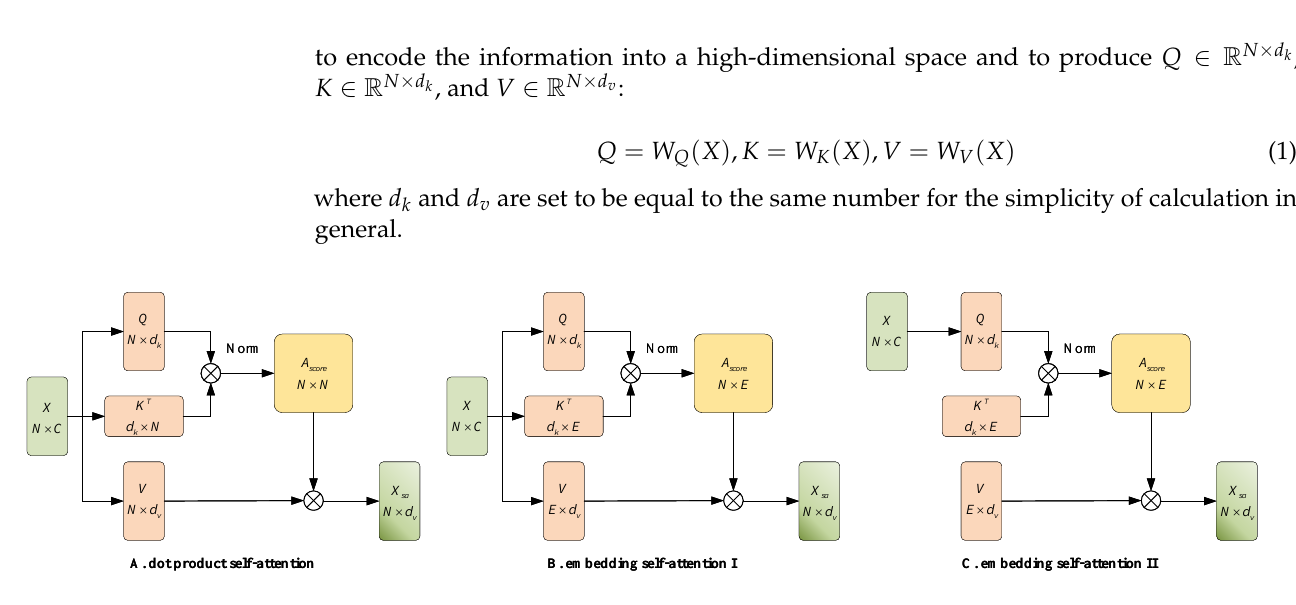
Figure 3. Dot product self-attention SA ( A ) and two kinds of embedding self-attention: EAM I ( B ) and EAM II ( C